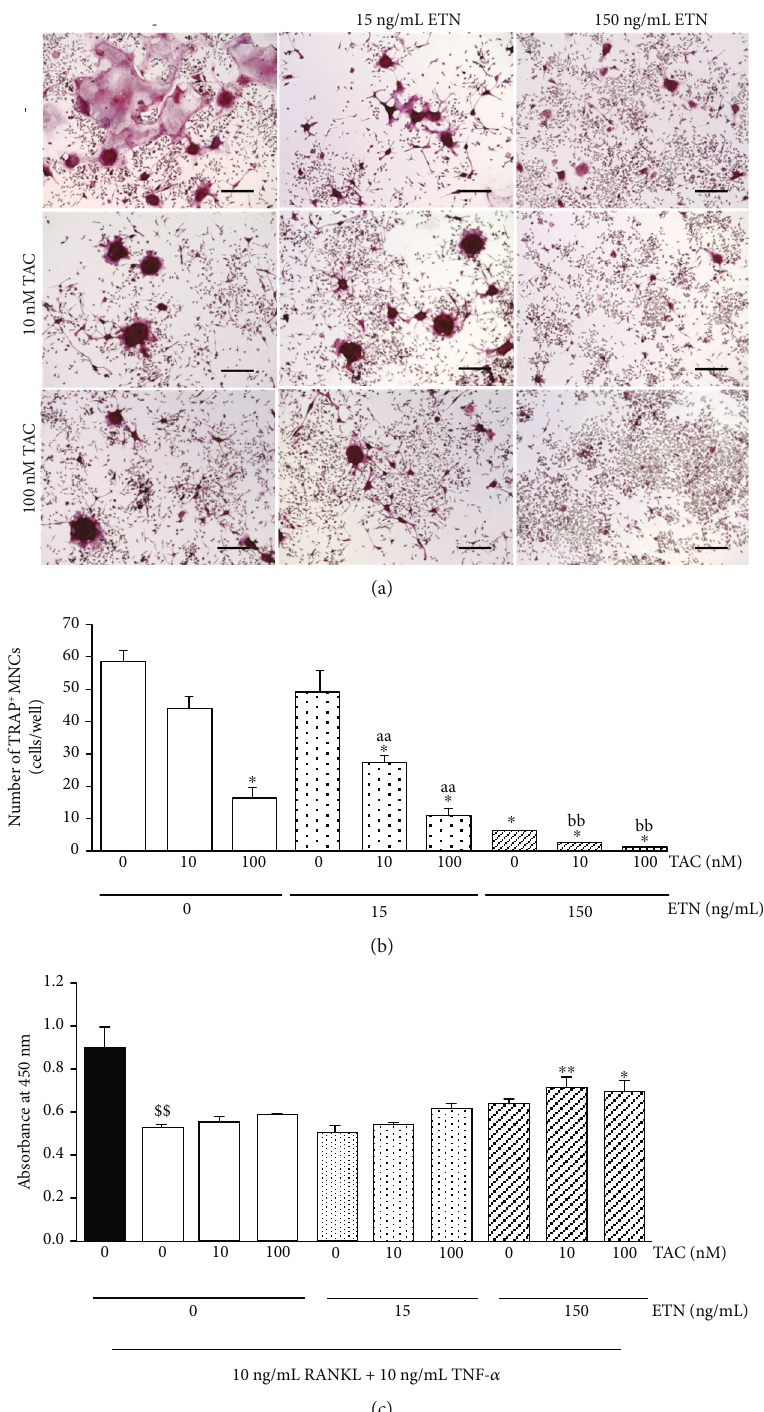
Figure 5: Etanercept (ETN) and tacrolimus (TAC) inhibit the di ff erentiation of RAW 264.7 cells into TRAP-positive multinuclear cells. RAW 264.7 cells were cultured in the presence of 10 ng/mL RANKL for 2 days and then stimulated with 10 ng/mL RANKL and 10ng/mL recombinant human TNF- α in the presence or absence of the drugs for 3 days and stained for TRAP. (a) Representative images of each drug treatment group are shown. Scale bar = 200 μ m . (b) Results are shown as the number of TRAP-positive multinuclear cells and the mean ± SEM ( n = 4 ). aa p < 0 : 01 compared with 15ng/mL ETN single-drug treatment; bb p < 0 : 01 compared with 150ng/mL ETN single-drug treatment; ∗ p < 0 : 01 compared with the no-drug treatment group (Dunnett ’ s multiple comparison test). (c) The results of single and concomitant drug treatments on cell viability under the in vitro osteoclastogenesis assay. Results are shown as absorbance at 450 nm and the mean ± SEM ( n = 4 ). $$ p < 0 : 01 compared with the nontreatment group (Aspin-Welch ’ s t -test). ∗ p < 0 : 05 and ∗∗ p < 0 : 01 compared with the no-drug treatment group (Dunnett ’ s multiple comparison